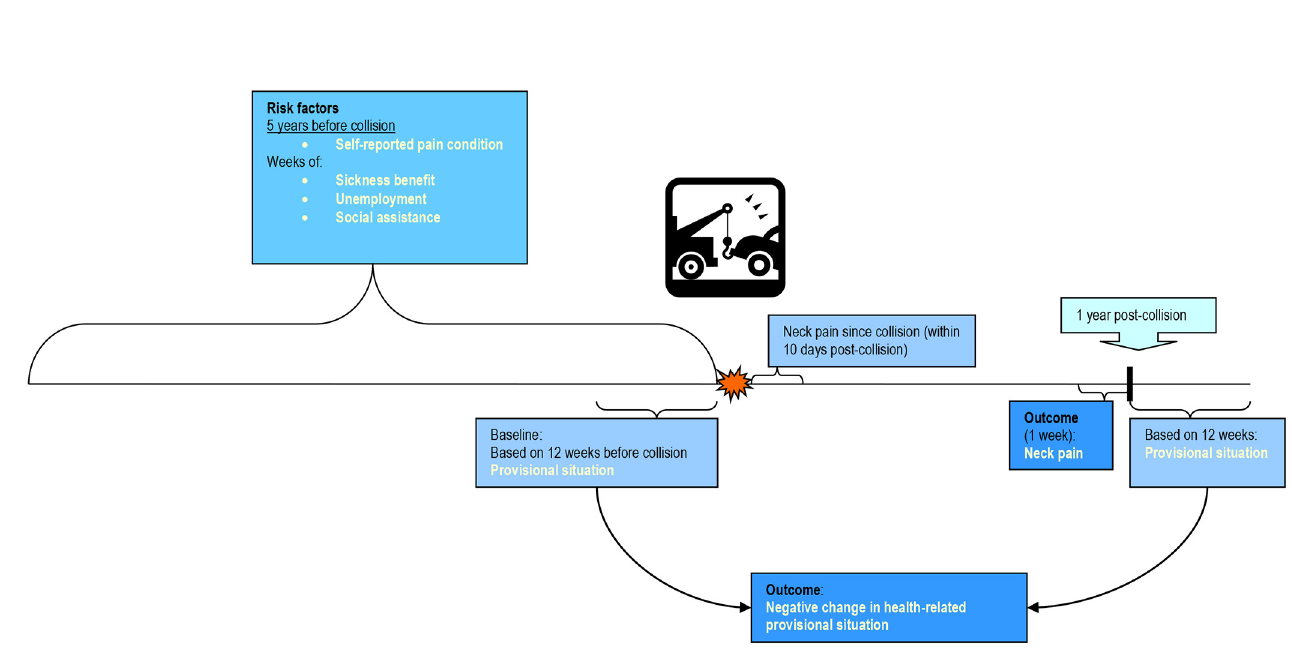
Fig 1. Time line of potential predictive factors and outcome